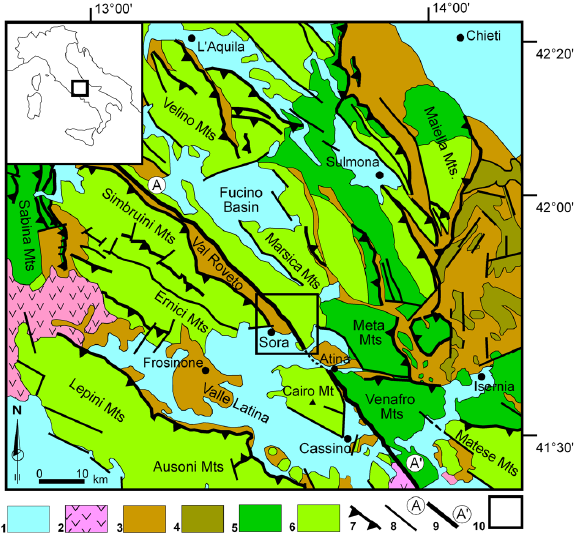
Figure 1. Simplified geological map of the central Apennines. Leg- end: 1) marine and continental clastic deposits (Pliocene-Quater- nary); 2) volcanic deposits (Pleistocene); 3) synorogenic hemipelagic and turbiditic sequences (Tortonian-Pliocene); 4) Molise-Sannio pelagic units (Cretaceous-Miocene); 5) slope and pelagic deposits (Lias-Miocene); 6) carbonate platform deposits (Trias-Miocene); 7) main thrust; 8) main normal and/or strike-slip fault; 9) Val Roveto - Atina Line; 10) location of the studied